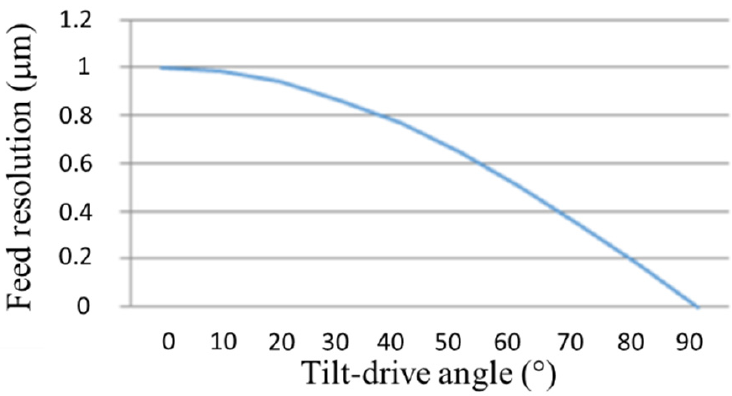
Figure 4. Feed resolution vs. tilt-drive angle.